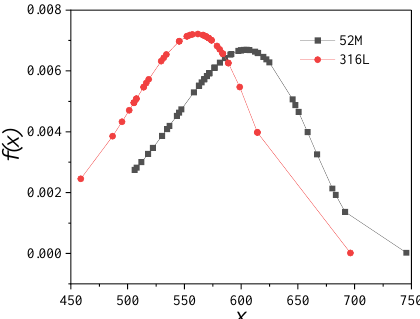
Figure 5. Weibull statistical distribution density function curve of yield strength.